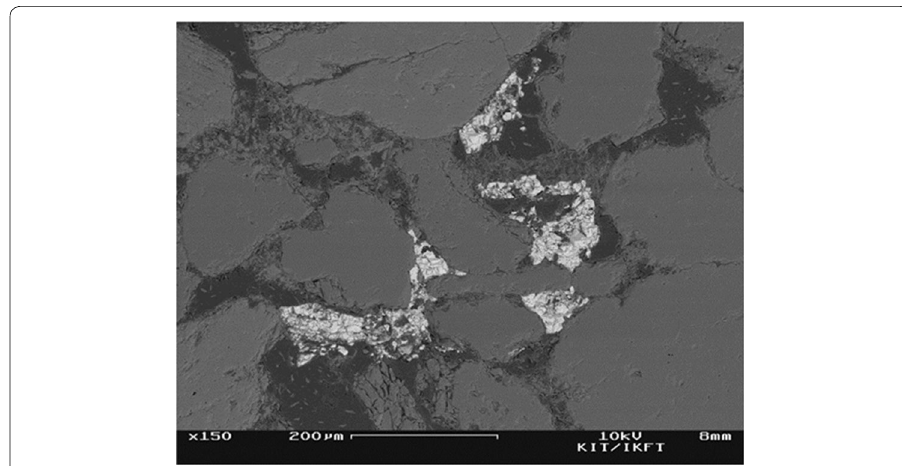
Fig. 14 Growth of barite crystals in some of the pore spaces, sample 7.2 (PV07; 60 °C/20 bar)